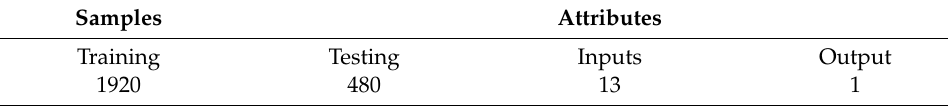
Table 9. Specification of atmospheric two-line data sets.